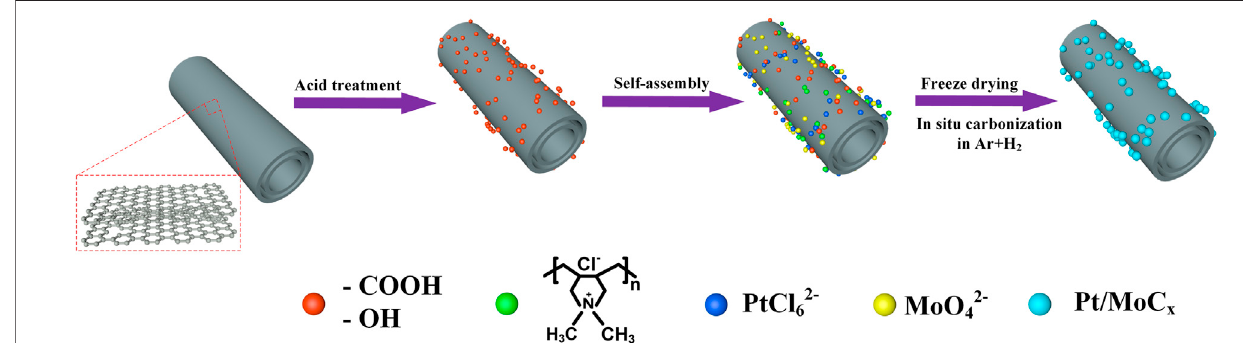
FIGURE 1 | Schematic diagram for synthesizing Pt/MoC x /MWCNTs.